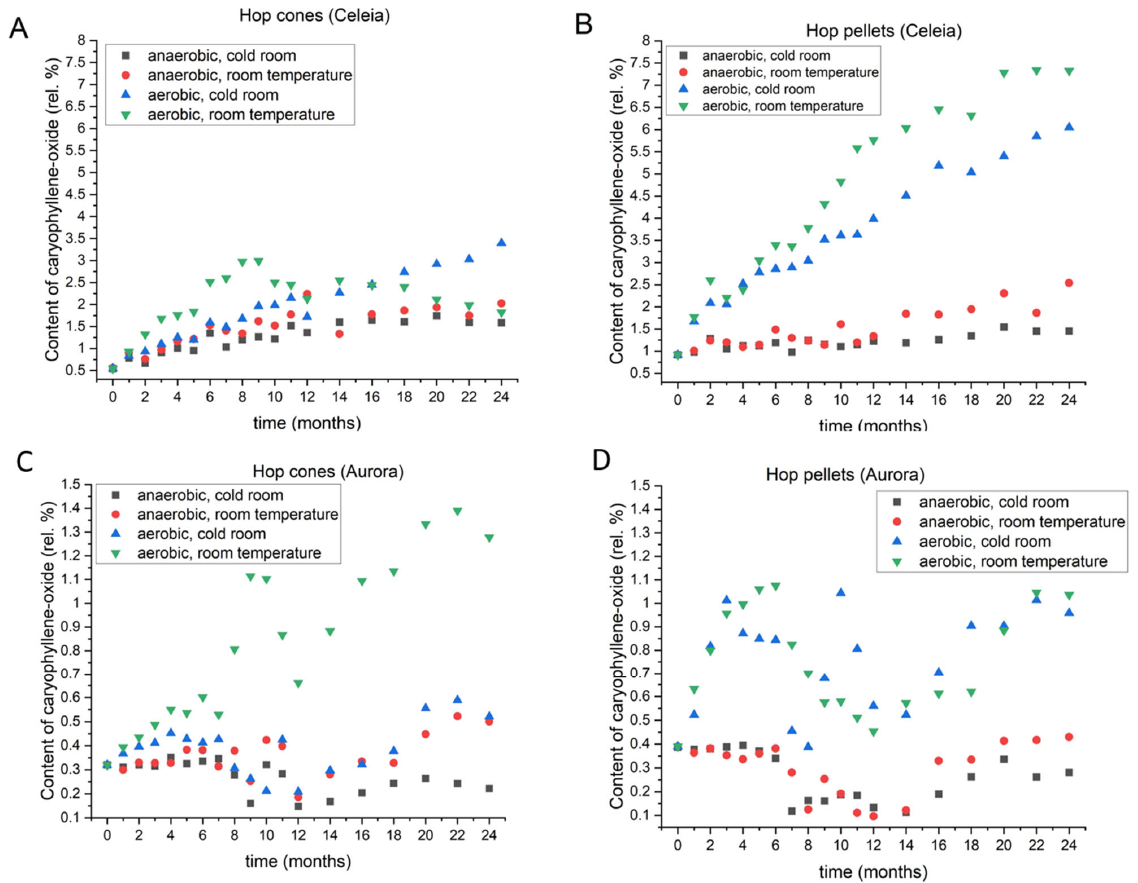
Figure 9. Changes in the content of caryophyllene-oxide in Celeia cones ( A ) and pellets ( B ) and Aurora cones ( C ) and pellets ( D ) during two-year period, under different storage